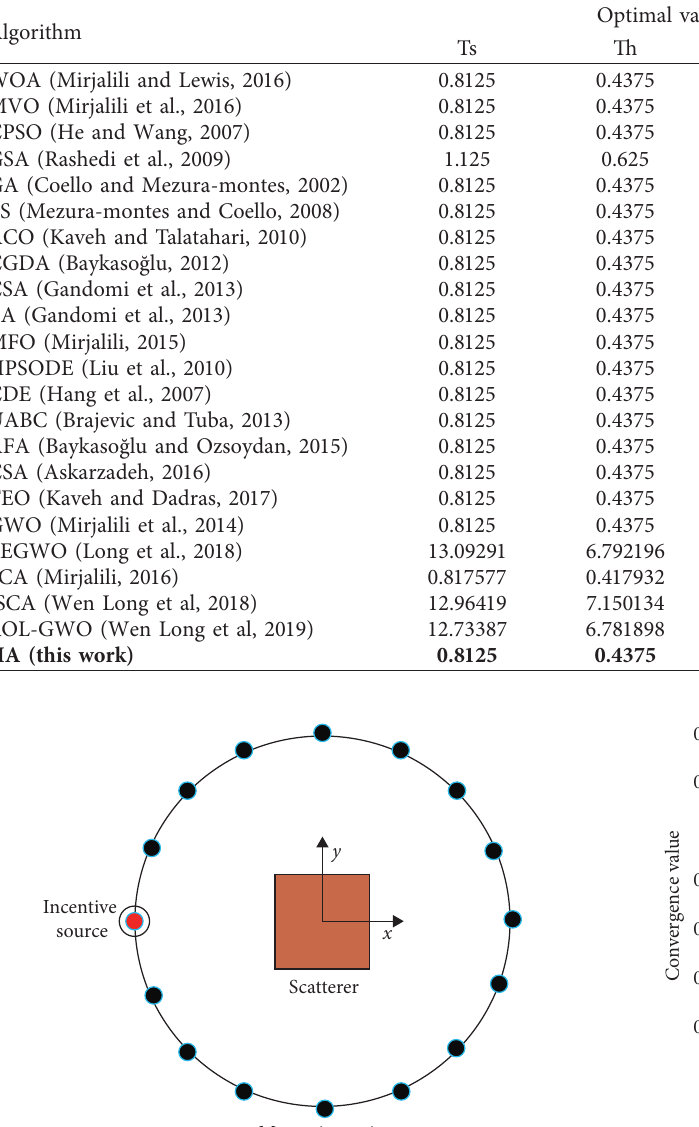
Table 5: The experimental results of HA and other algorithms for pressure vessel design problem.